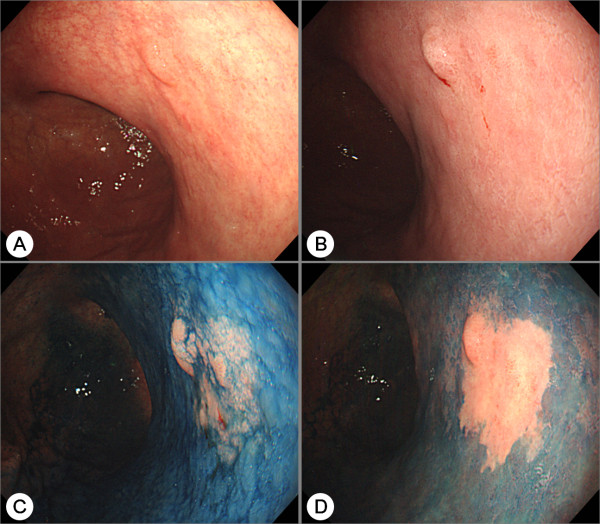
Chromoendoscopy of a differentiated adenocarcinoma. (A) A combined flat and elevated lesion with an unclear border at the lower body of the stomach is shown. (B) Endoscopic view after acetic acid was sprinkled. (C) Endoscopic view after indigo carmine was additionally sprinkled. (D) Endoscopic view after the lesion was washed with clean water. After chromoendoscopy with indigo carmine dye added to acetic acid, the lesion's borders became distinct and the clarity of the image is high. The lesion was resected by endoscopic submucosal dissection and was shown to be a differentiated adenocarcinoma.